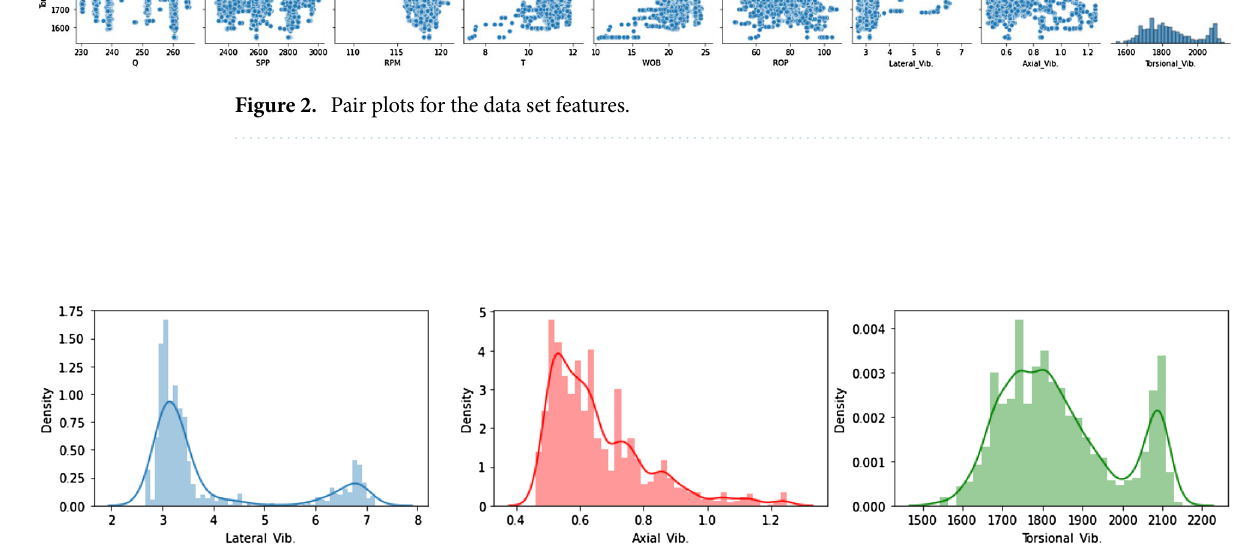
Figure 3. Vibration data